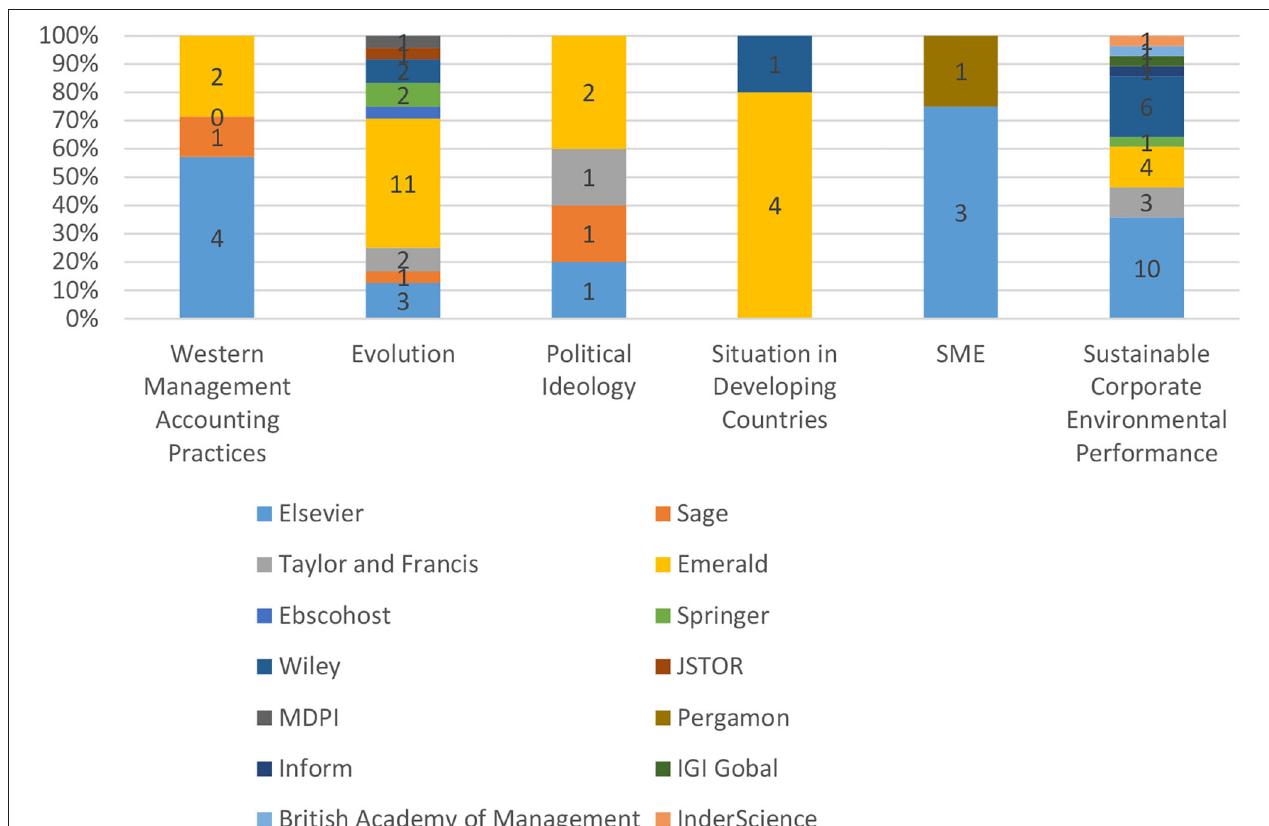
FIGURE 3 | Subject theme-wise details of 73 articles